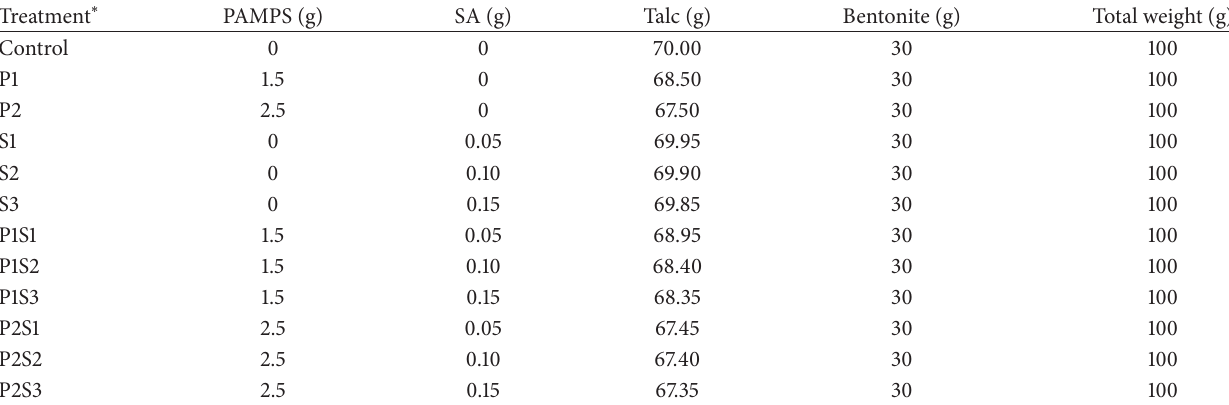
Table 2: The different formulas of tobacco seed pelleting